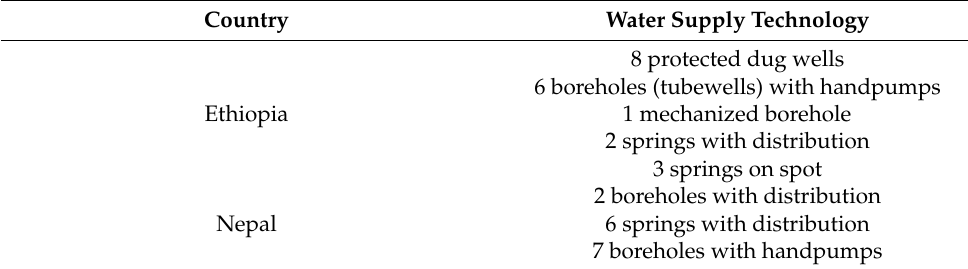
Table 2. Types of water supply technology at study